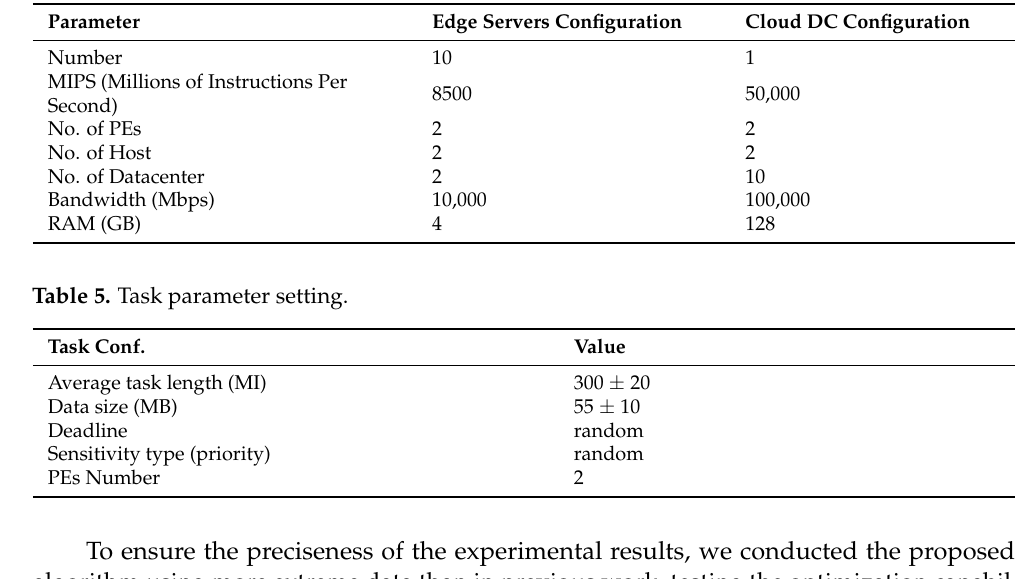
Table 4. Resource configuration.